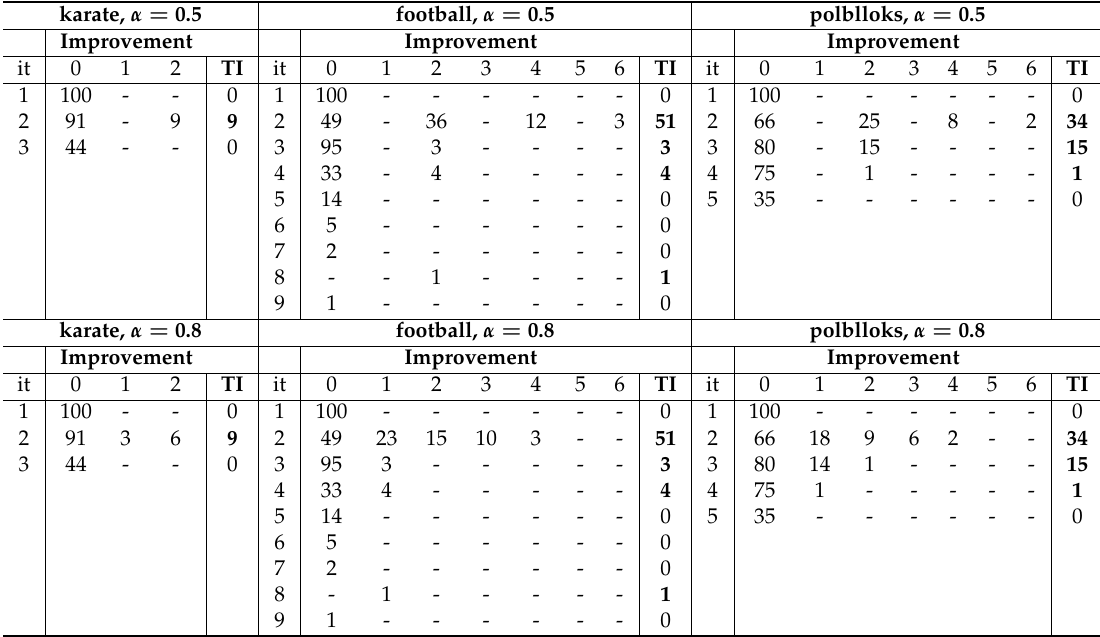
Table 3. Table of improvements per iteration for three real networks, values are given in percentage (%).